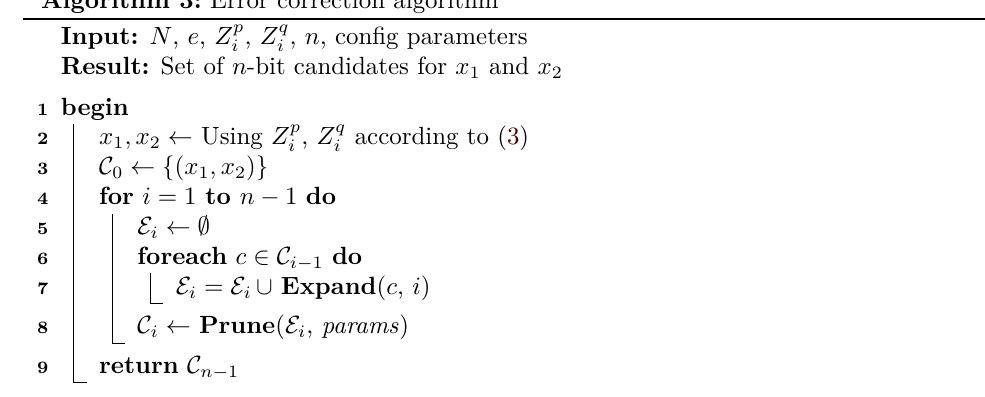
Algorithm 3: Error correction algorithm